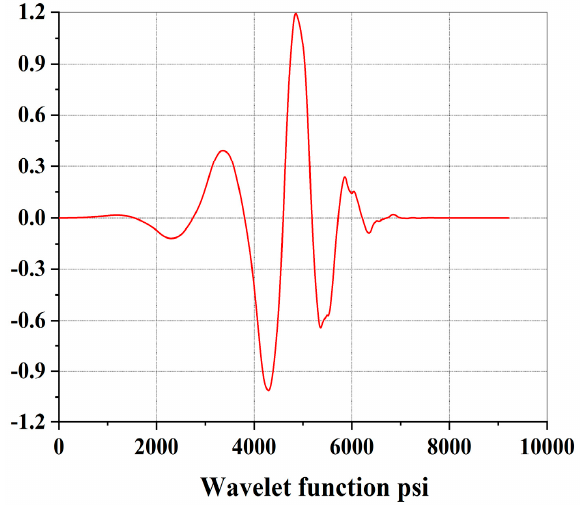
Figure 7. Wavelet function.